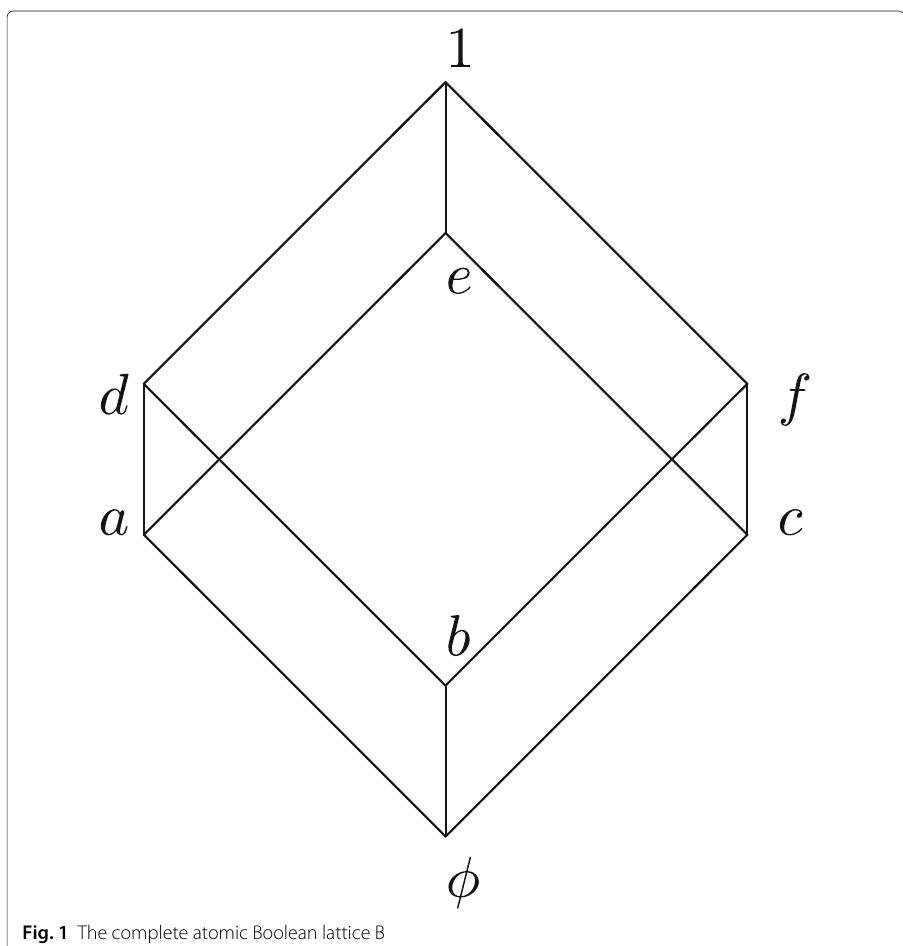
Fig. 1 The complete atomic Boolean lattice